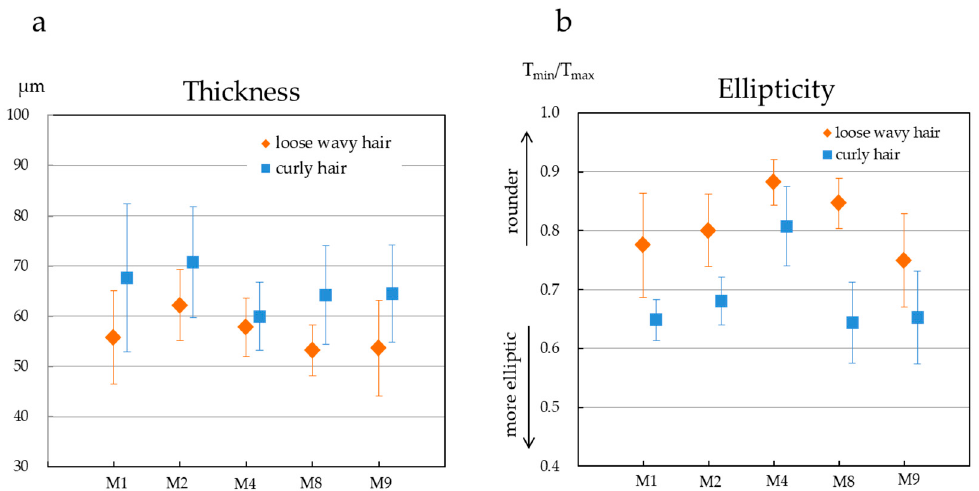
Figure 3. Thickness and ellipticity of mixed hairs. ( a ) Thickness; ( b ) ellipticity. In all cases there were statistically significant differences between loose wavy and curly hairs (p < 0.01).